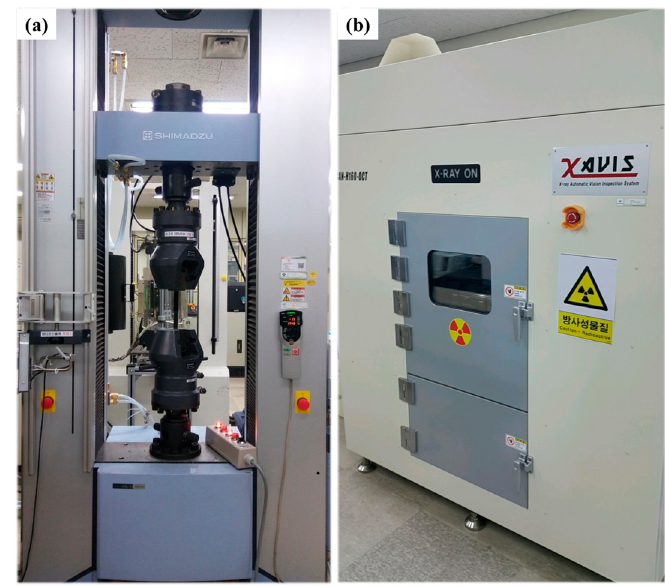
Figure 2. Test equipment. ( a ) Universal tensile testing machine; ( b ) radiographic inspection testing machine.